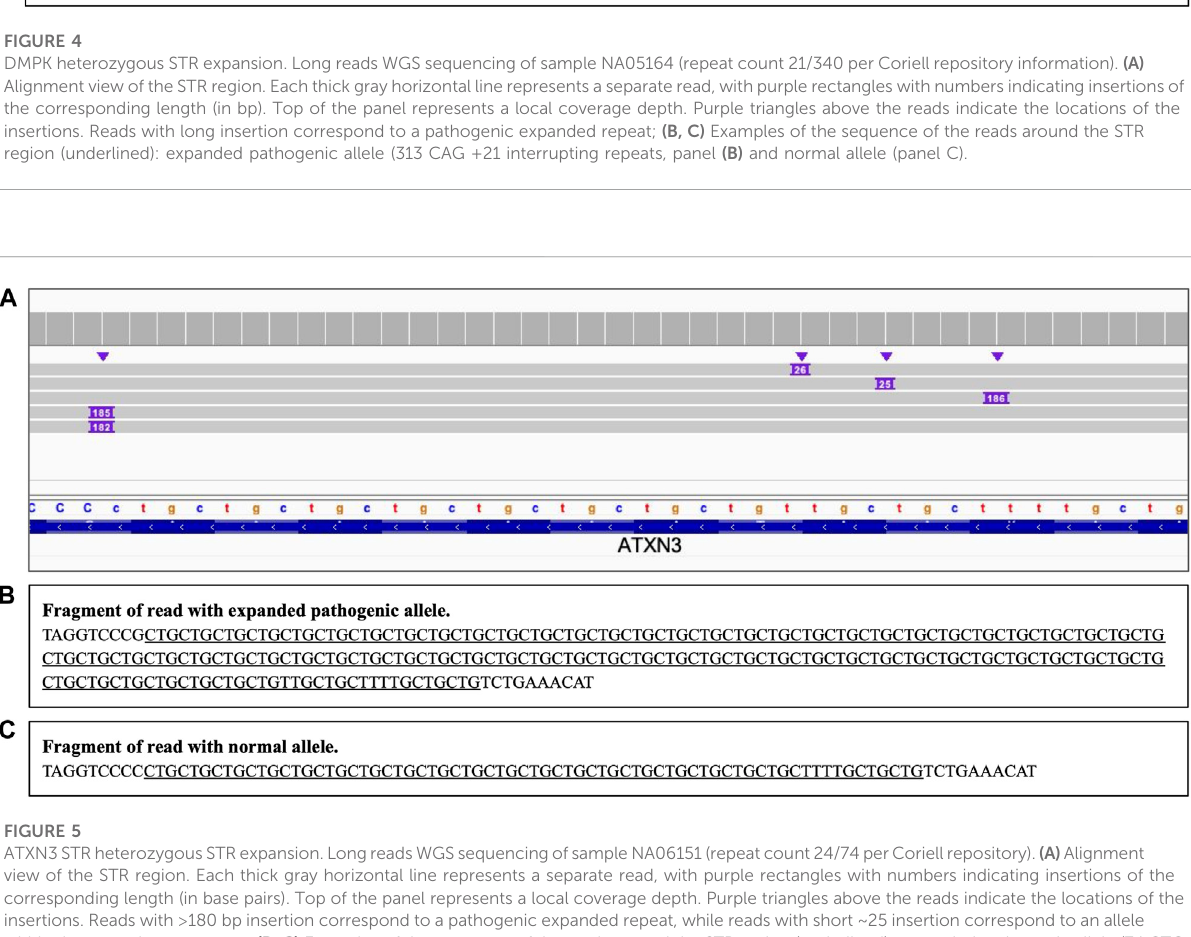
FIGURE 5 ATXN3STRheterozygousSTRexpansion.LongreadsWGSsequencingofsampleNA06151(repeatcount24/74perCoriellrepository). (A) Alignment view of the STR region. Each thick gray horizontal line represents a separate read, with purple rectangles with numbers indicating insertions of the corresponding length (in base pairs). Top of the panel represents a local coverage depth. Purple triangles above the reads indicate the locations of the insertions. Reads with > 180 bp insertion correspond to a pathogenic expanded repeat, while reads with short ~25 insertion correspond to an allele within the normal repeat range; (B, C) Examples of the sequence of the reads around the STR region (underlined): expanded pathogenic allele (74 CTG +3 interrupting repeats, panel (B) and normal allele (panel